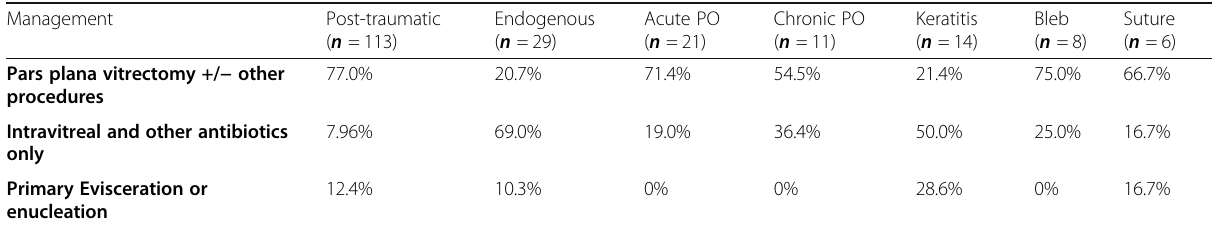
Table 3 Management of endophthalmitis cases among the different groups ( n = 202). The majority of patients underwent PPV except in the endogenous and keratitis groups where management was mostly medical. Keratitis-induced endophthalmitis was associated with the highest rates of primary evisceration and enucleation